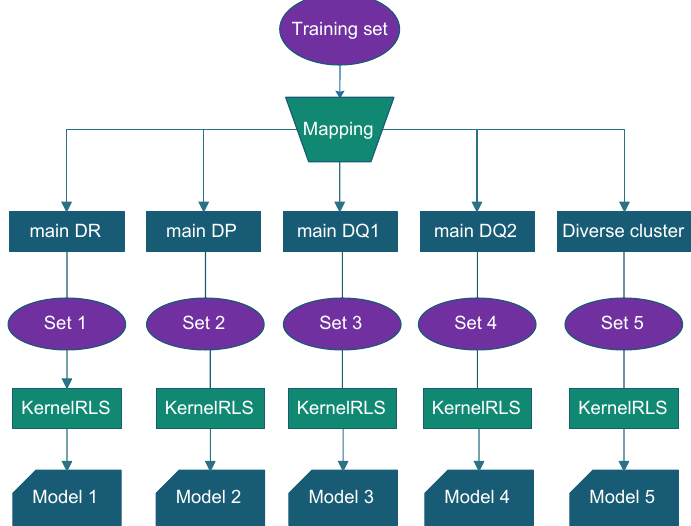
Figure 4. Schematic illustration of generating multiple prediction models.